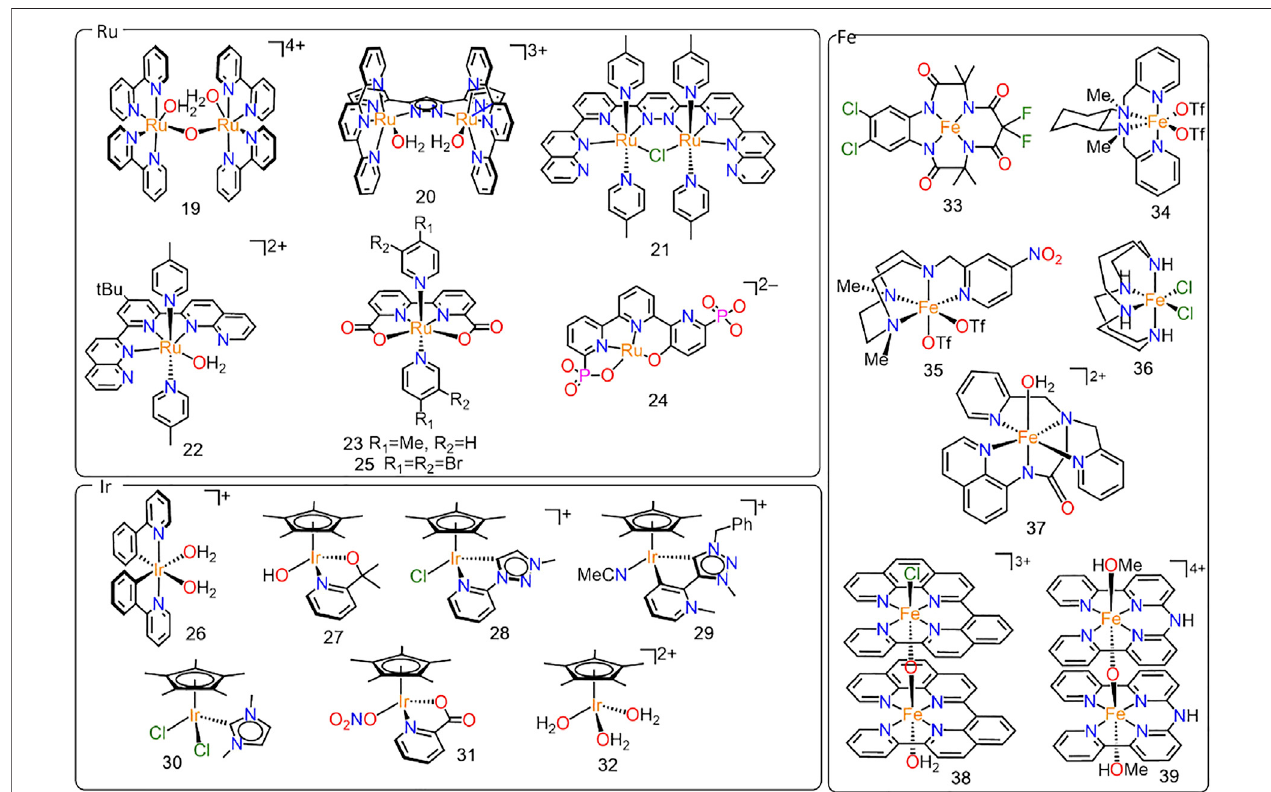
FIGURE 4 | Structures of ruthenium ( 19 – 25 ), iridium ( 26 – 32 ) and iron ( 33 – 39 ) based water oxidation catalysts.